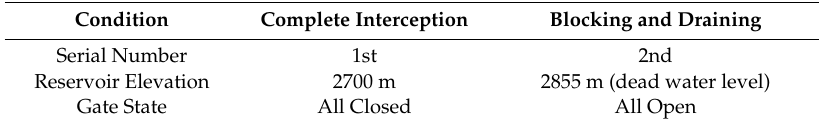
Figure 4. Layout of the Yebatan arch dam. Table 1. Parameter design for complete interception and comprehensive flood control of blocking and draining.